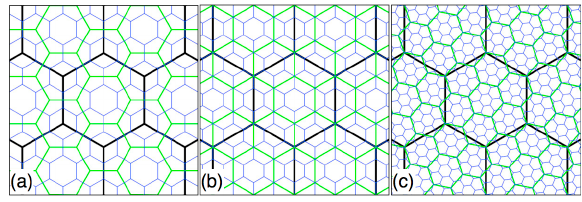
Figure 1. Multi-precision hexagonal grids of aperture 3, 4, and 7